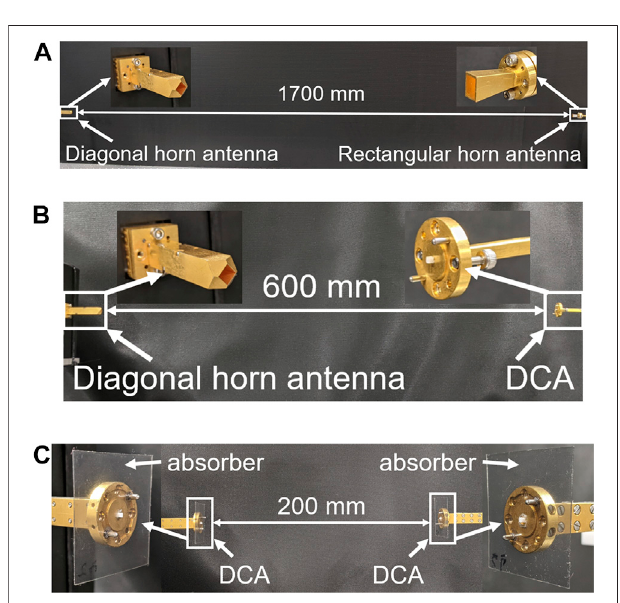
FIGURE 7 | Photographsofthreetransmissionexperiments. (A) Experiment I. Tx, Rectangular horn antenna; Rx, Diagonal horn antenna. (B) Experiment II. Tx, DCA; Rx, Diagonal horn antenna. (C) Experiment III. Tx, DCA; Rx,